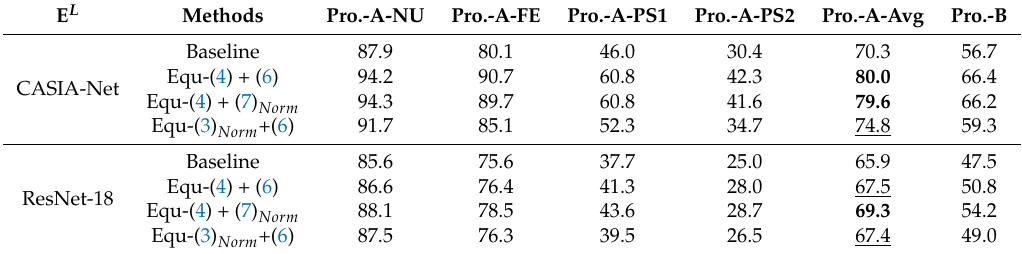
Table 9. Rank-1 identification rates (%) of fusion-based network in face recognition on low-quality data sets under variations. The results in ’Pro.-A-Avg’ are the average rates of specific methods in Test set A, and the results of the positive combinations are made bold, but the negative ones are added underline. The last column gives the overall performance in Test set